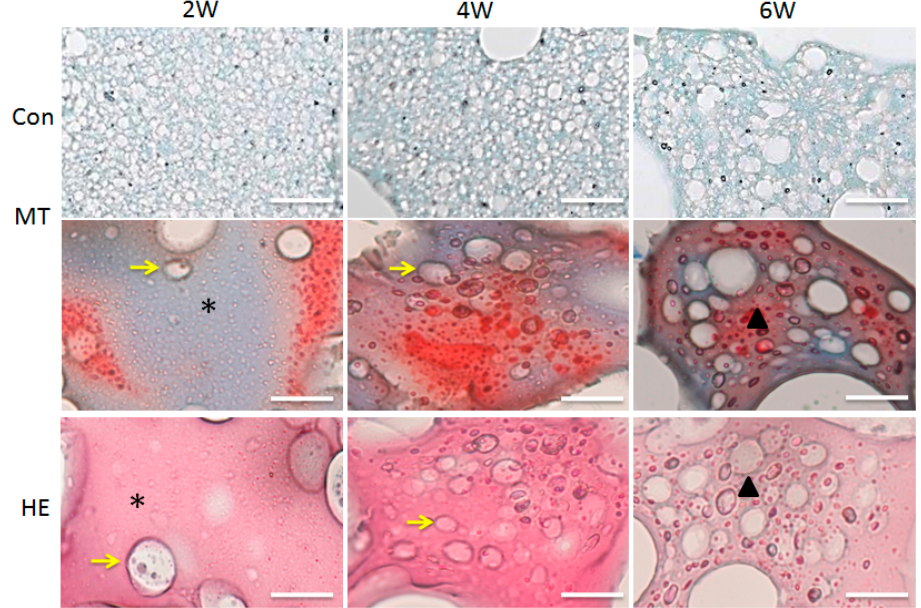
Figure 6. Histological examination of in vitro chondrogenesis: At 2 weeks, the cartilaginous matrix (black stars), immature lacuna (yellow arrows). At 4 weeks, the cartilaginous matrix contained a larger number of lacunae (yellow arrows). At 6 weeks, auricular cartilage (triangles) was visible. Scale bars = 200 μ m.